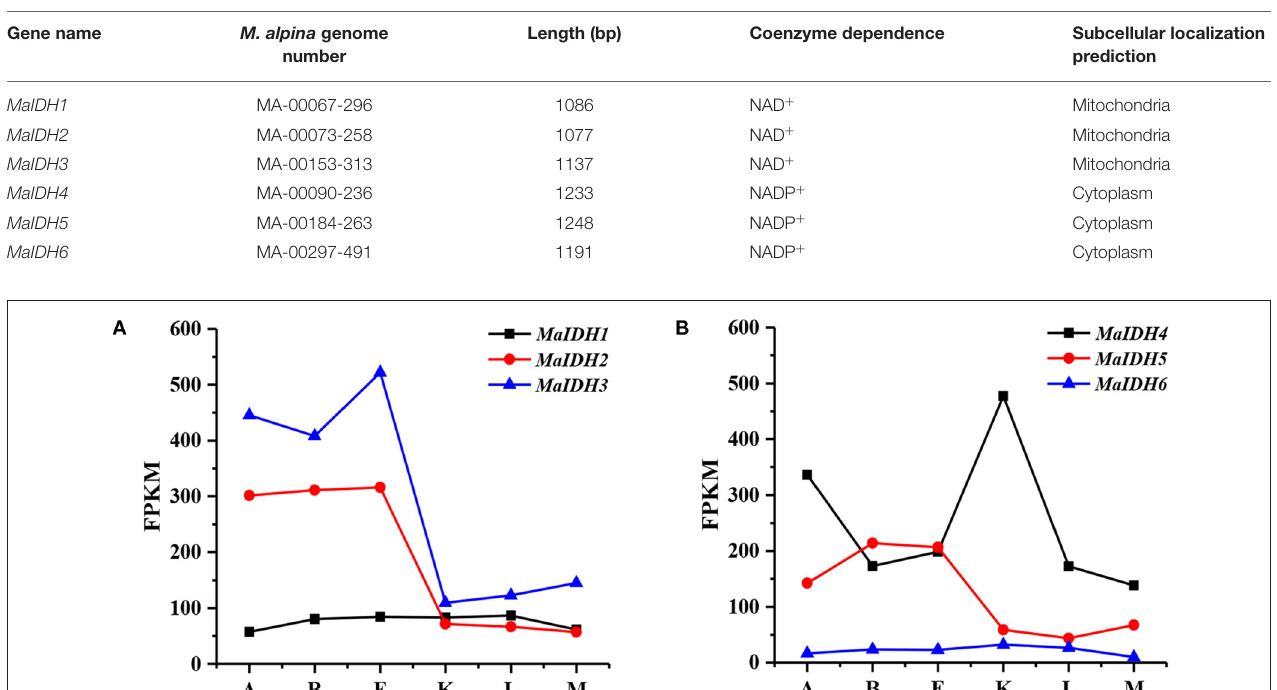
TABLE 1 | Information for the isocitrate dehydrogenases from M. alpina (MaIDHs).